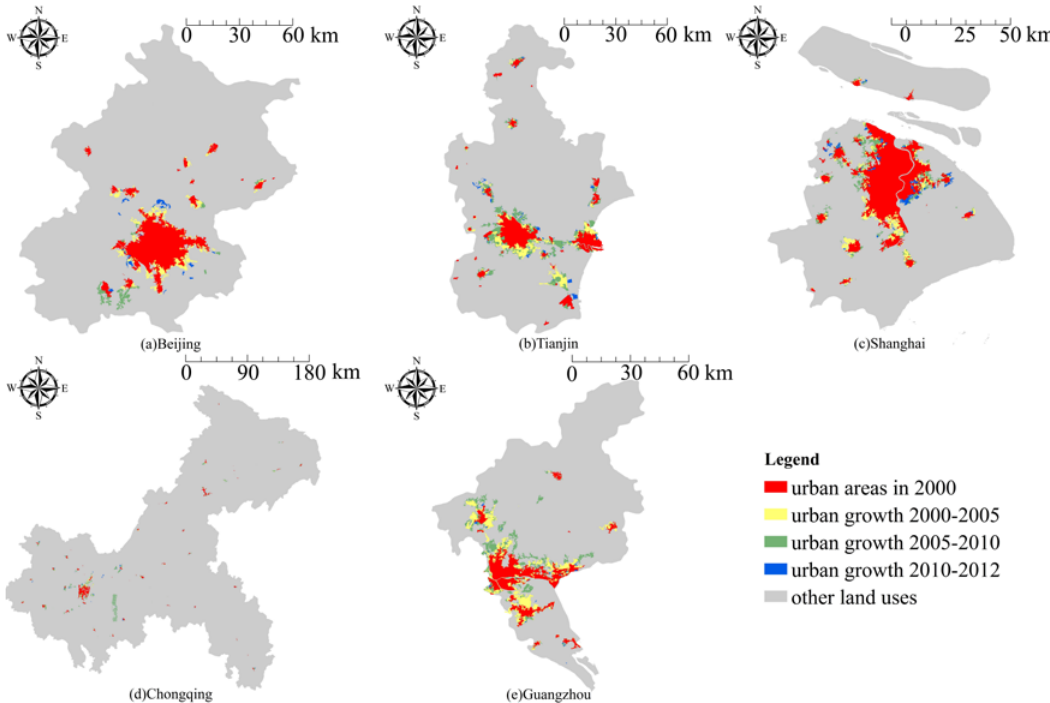
Figure 2. Changes in urban built-up areas between the years 2000–2012 in ( a ) Beijing; ( b ) Tianjin; ( c ) Shanghai; ( d ) Chongqing; and ( e ) Guangzhou. Table 3. Description of landscape metrics used in the